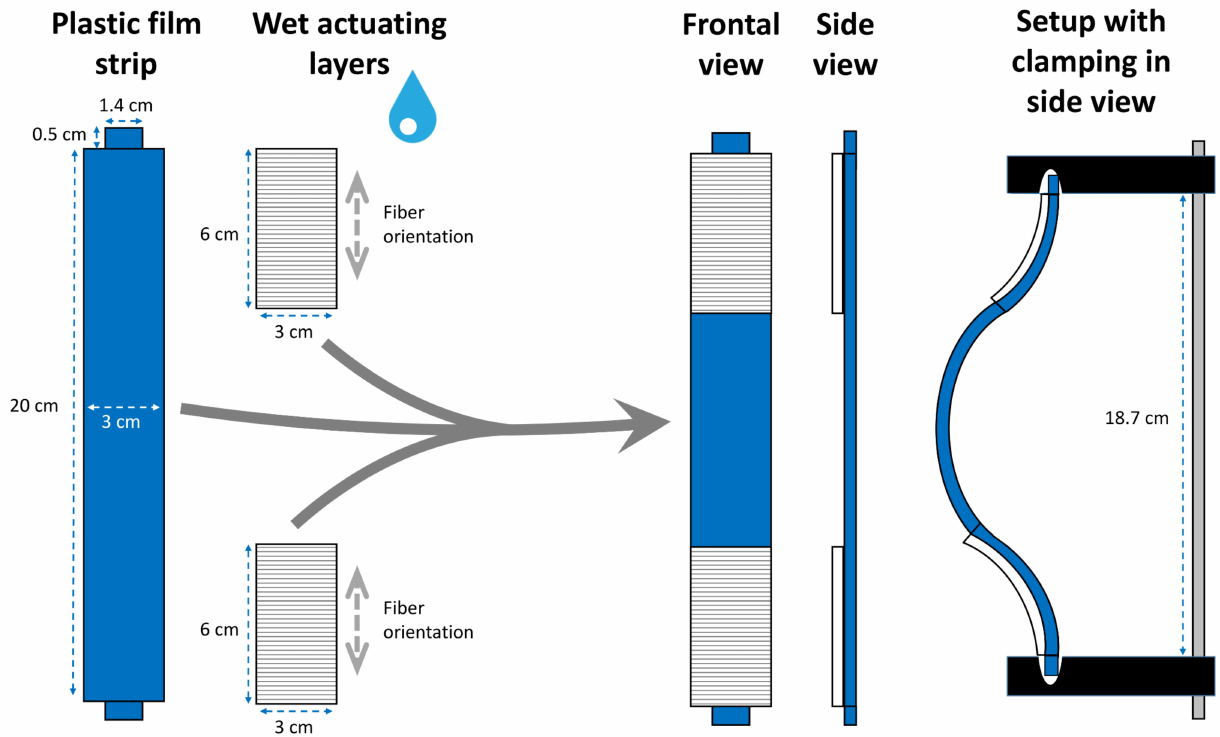
Figure 7. Exemplary construction scheme for the abstraction of snap-through instability as present in the Venus flytrap ( D. muscipula ) and its transfer into a paper-based self-actuated compliant system. The fiber orientations of the wet ALs are indicated (gray dashed arrows). Details are provided in the main